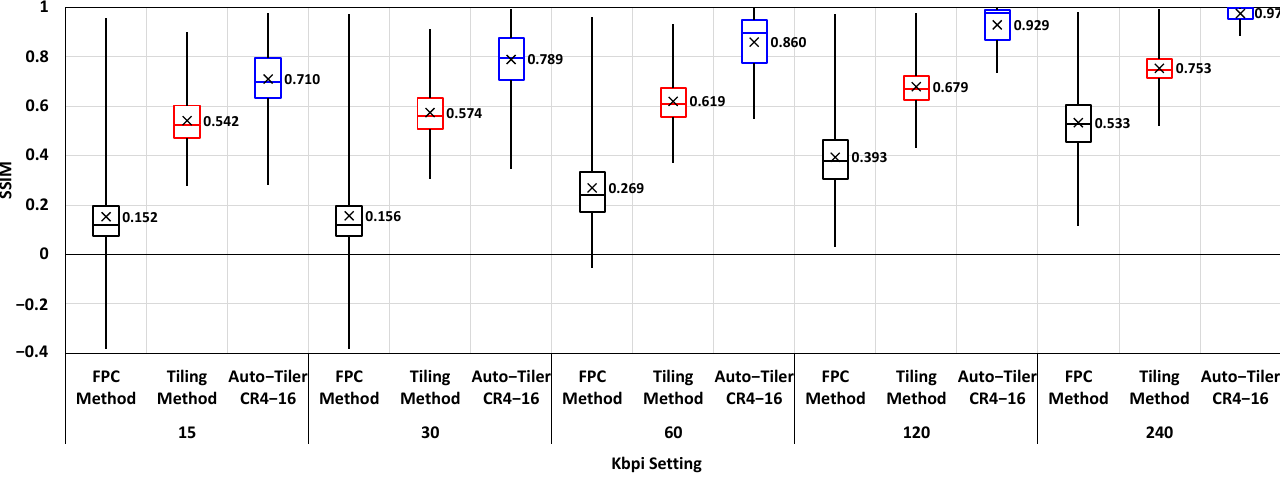
Figure 10. Structural similarity (SSIM) measurement result for FPC, tiling, and auto-tiler method at different Kbpi